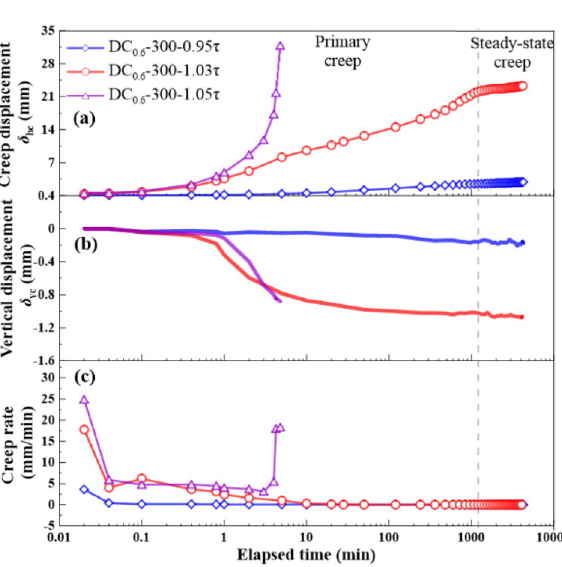
Figure 12. Relationships of ( a ) creep displacement ( δ hc ) versus elapsed time, ( b ) vertical displacement ( δ vc ) versus elapsed time, and (c) creep rate versus elapsed time for the reinforced specimens at ω = 18% under σ n = 300